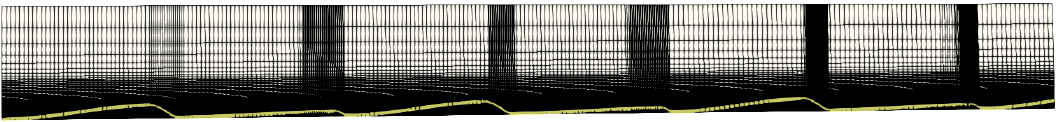
Figure 11. Mesh for flow over 3D dunes.